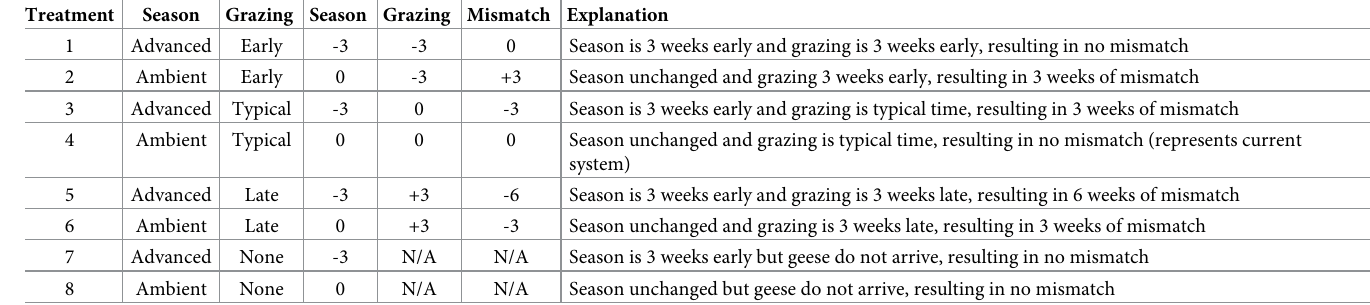
Table 1. Experiment treatments. Season indicates timing of season advancement treatment: 3 weeks early (-3) and was ambient (0). Grazing indicates timing of goose grazing treatment: 3 weeks early (-3), typical (0) and 3 weeks late (+3). A negative mismatch indicates an advanced season relative to grazing; positive mismatch indicates advanced grazing relative to the season. There are more negative mismatches than positive because we only advanced the growing season while we advanced and delayed grazing. N/A = no mismatch because no goose arrival